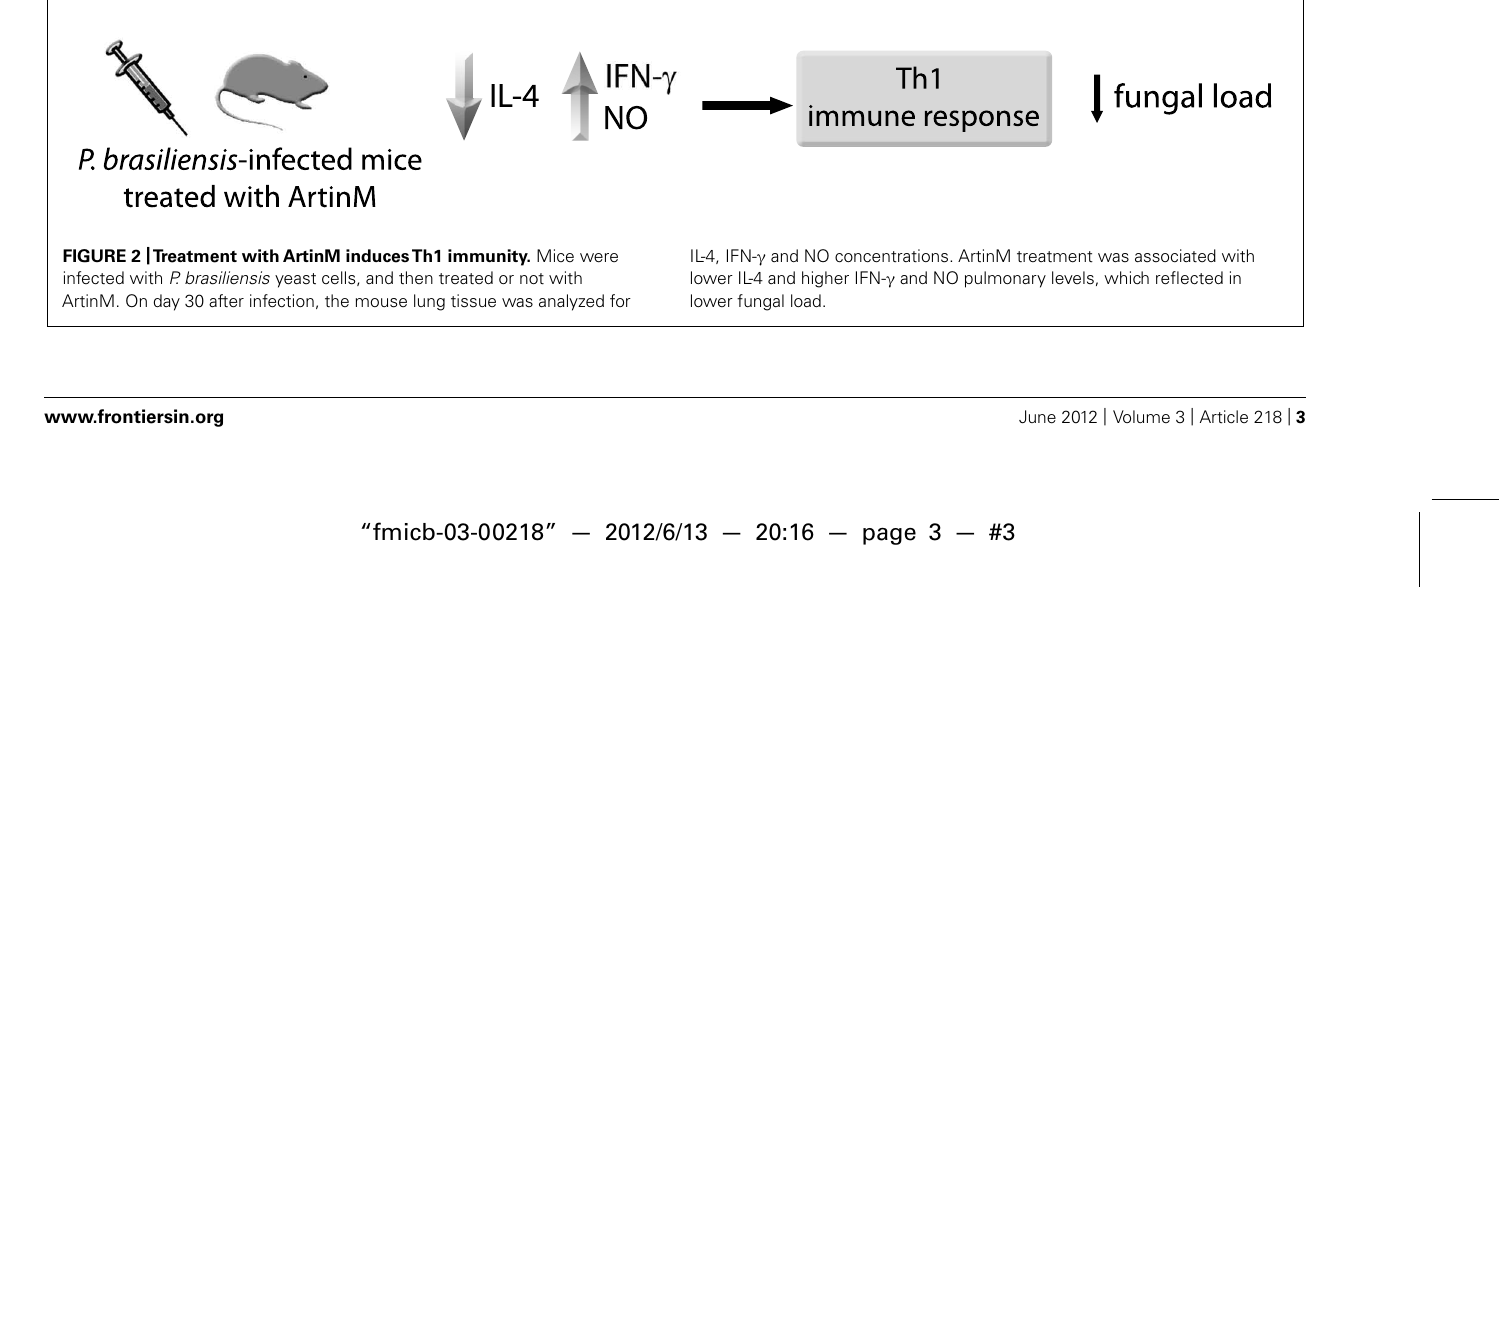
FIGURE 1 |ArtinM administration prevents pulmonary lesions in P. brasiliensis -infected mice. Lung histopathology of uninfected mice (A) , P. brasiliensis -infected mice (B) , and P. brasiliensis -infected mice treated with ArtinM (C) . P. brasiliensis -infected mice display extensive and confluent